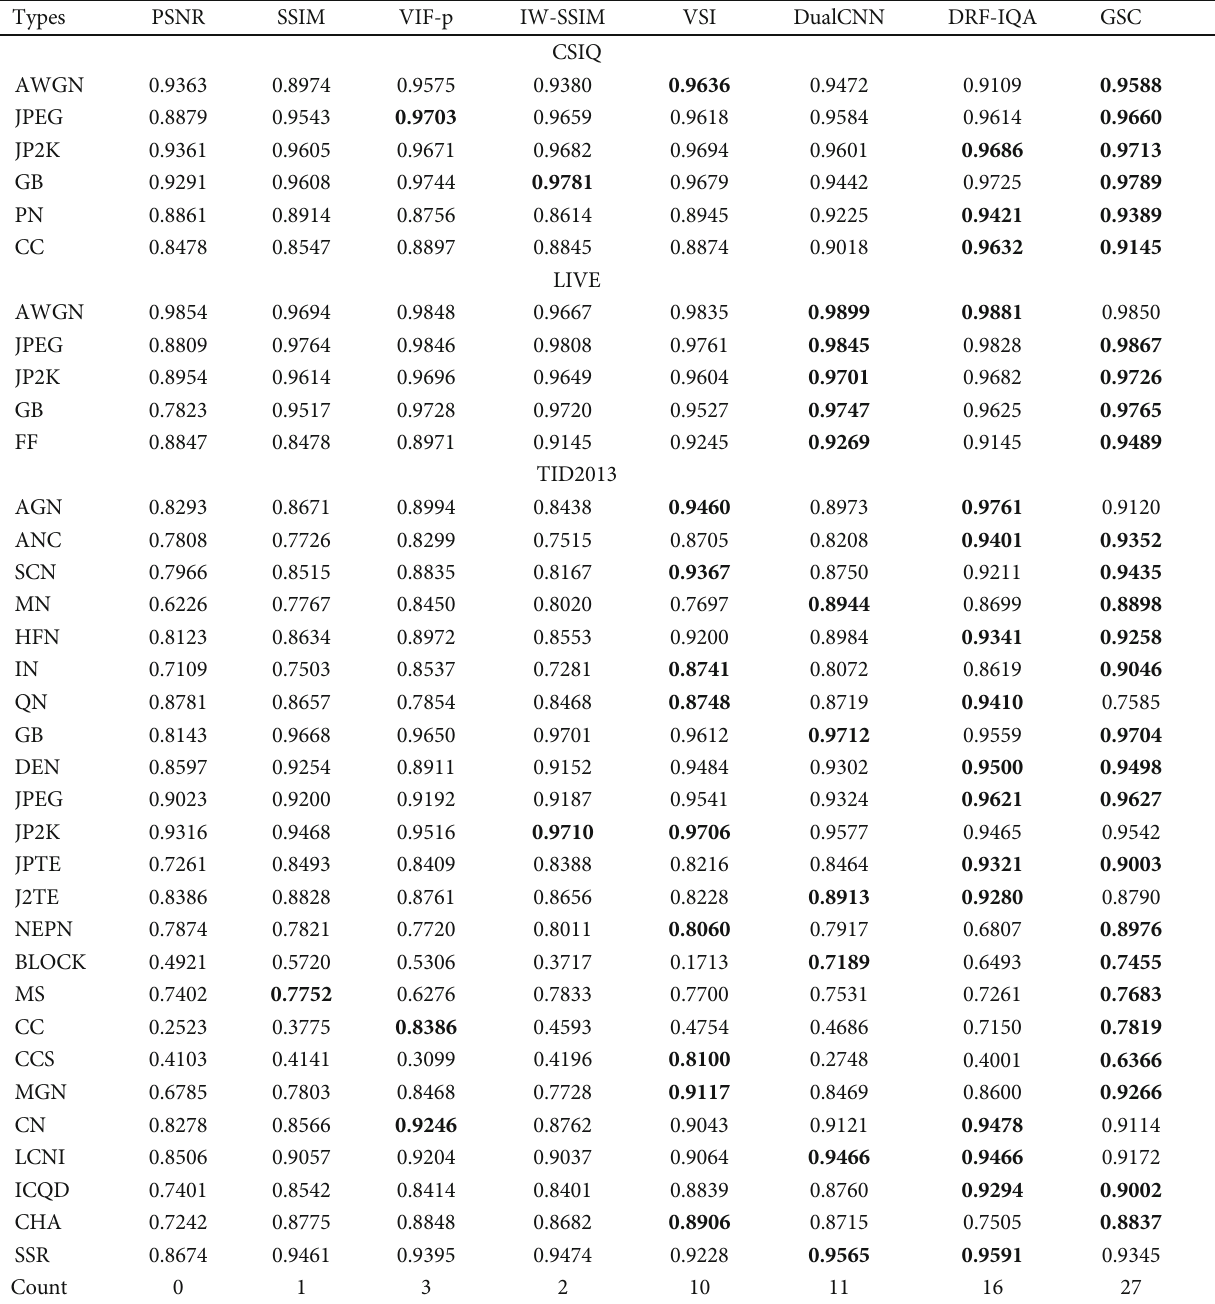
Table 3: SROCC scores for the 8 IQMs with individual distortion types in the CSIQ, LIVE, and TID2013